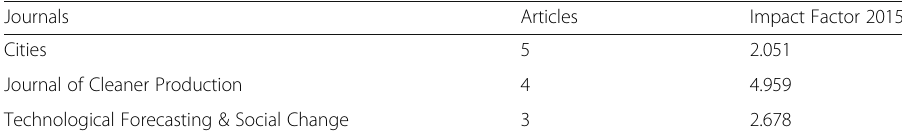
Table 4 Journals with high quantity of articles Journals Articles Impact Factor 2015 Cities 5 2.051 Journal of Cleaner Production 4 4.959 Technological Forecasting & Social